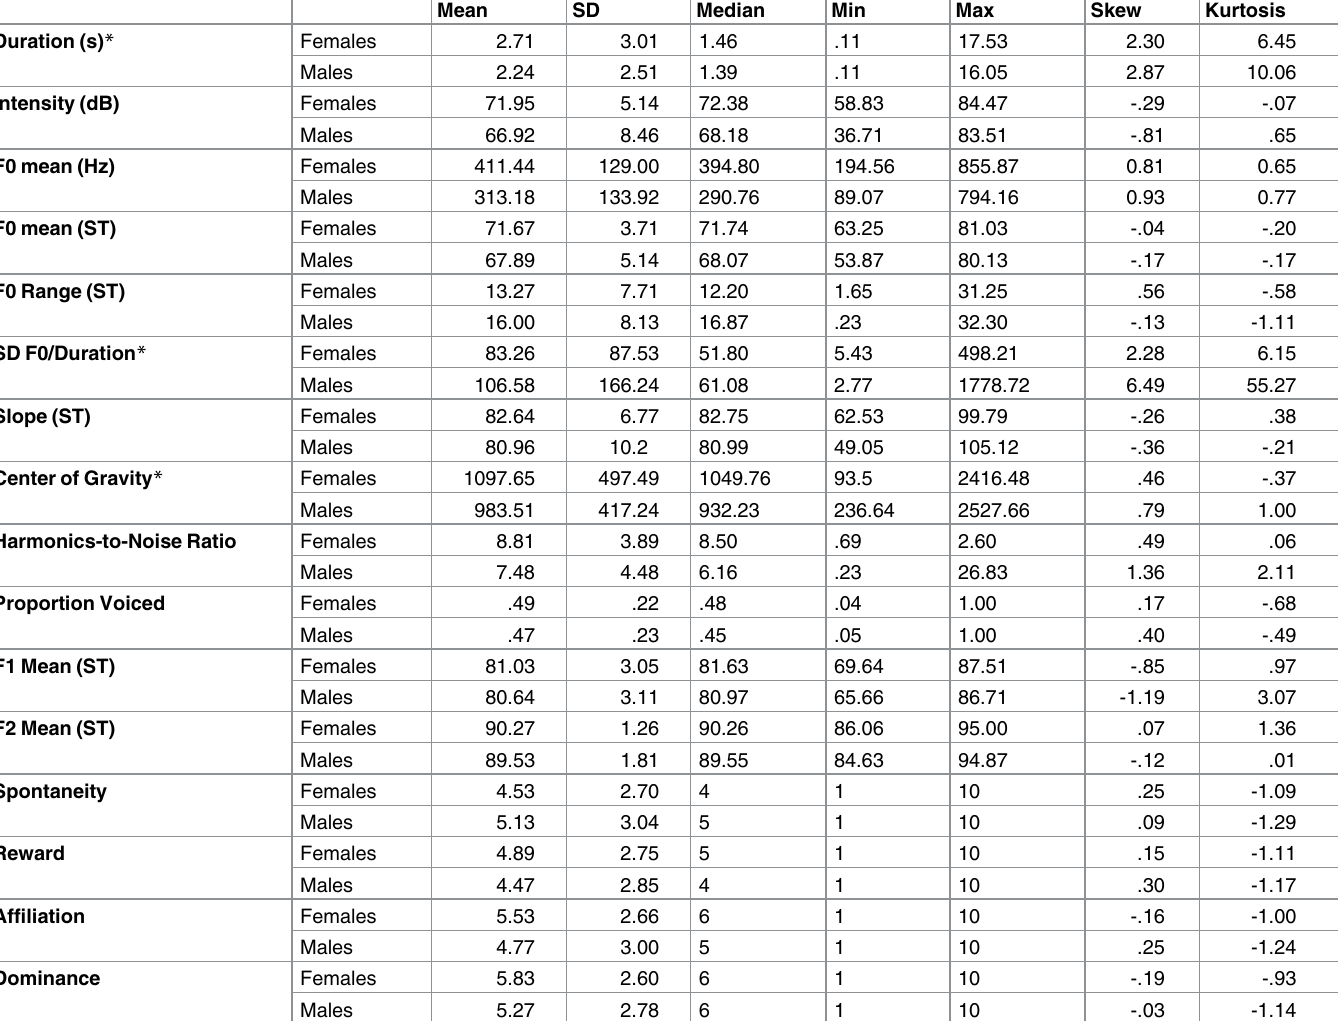
Table 2. Summarystatistics for the 11 acoustic measuresand subjective ratings for the 395 laughs included in the key analyses, separated by the sex of the actor (female n = 142, male n =